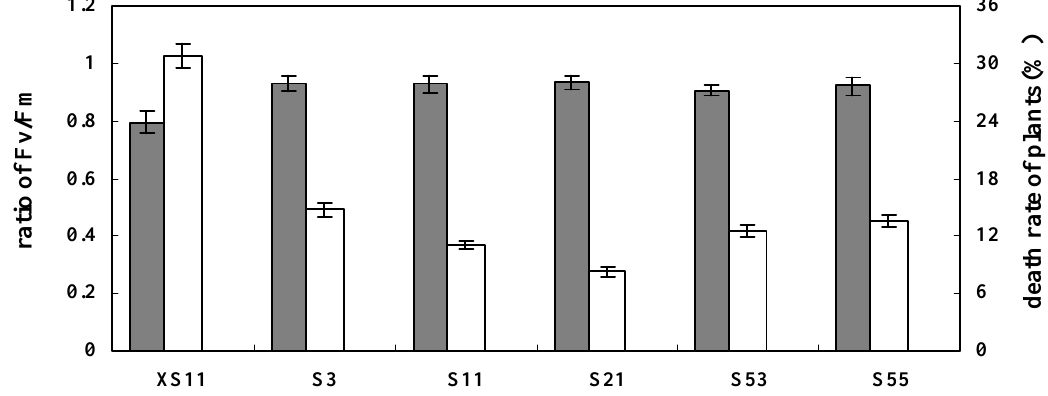
Figure 4. The recovery growth of rice plant after salt